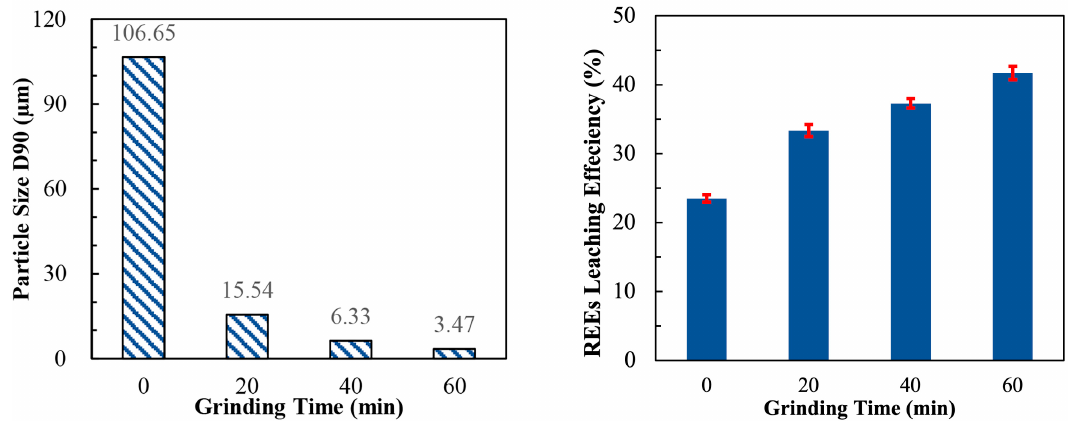
Figure 7. The effect of grinding time on the particle size and REE leaching efficiency of CFA.